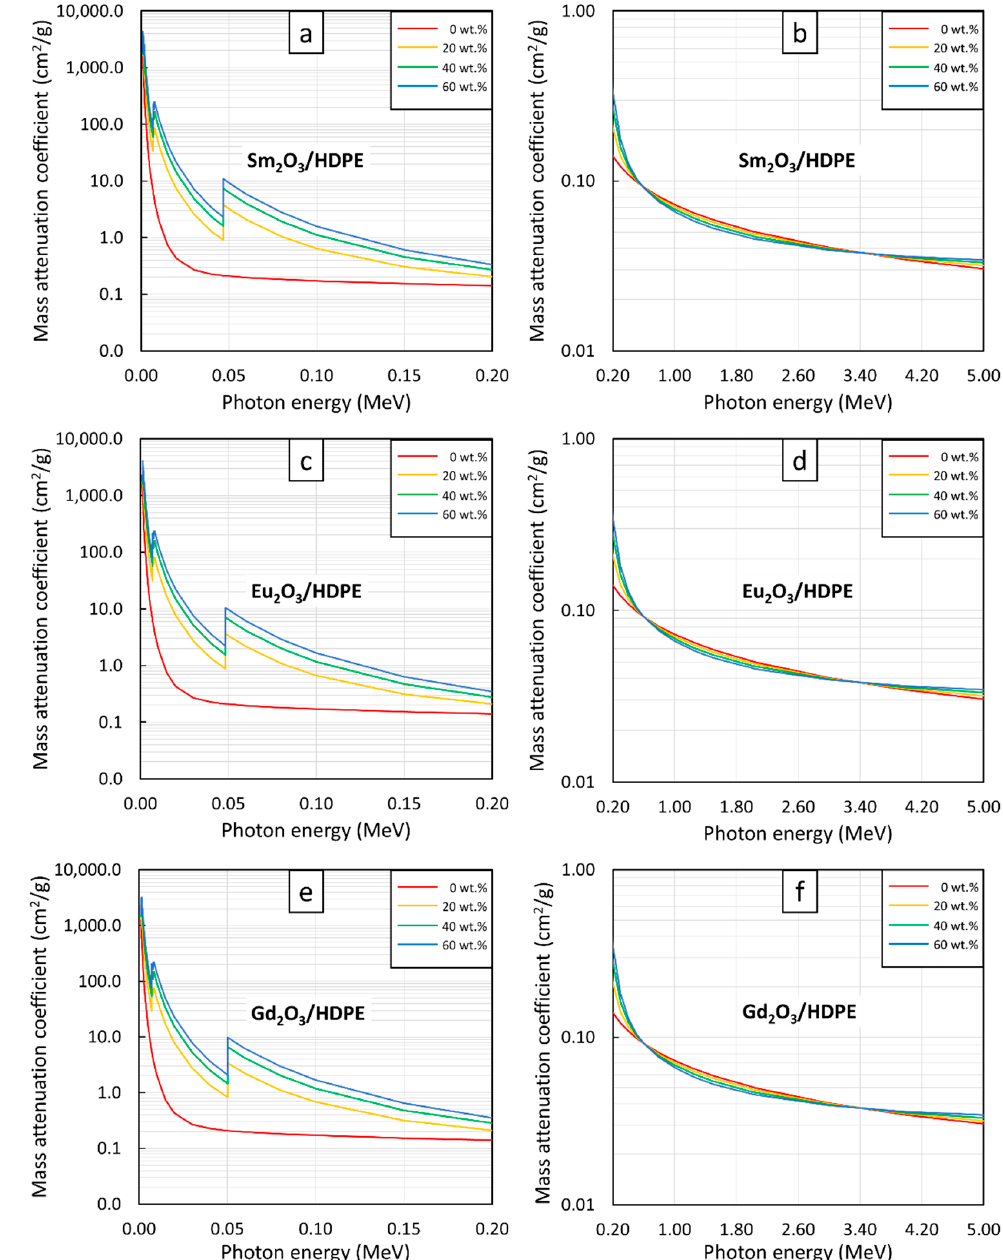
Figure 1. μ m values of ( a , b ) Sm 2 O 3 /HDPE, ( c , d ) Eu 2 O 3 /HDPE, and ( e , f ) Gd 2 O 3 /HDPE composites with filler contents of 0, 20, 40, and 60 wt.%, determined at photon energies of ( a , c , e ) 0.001–0.2 MeV and ( b , d , f ) 0.2–5 MeV using XCOM.